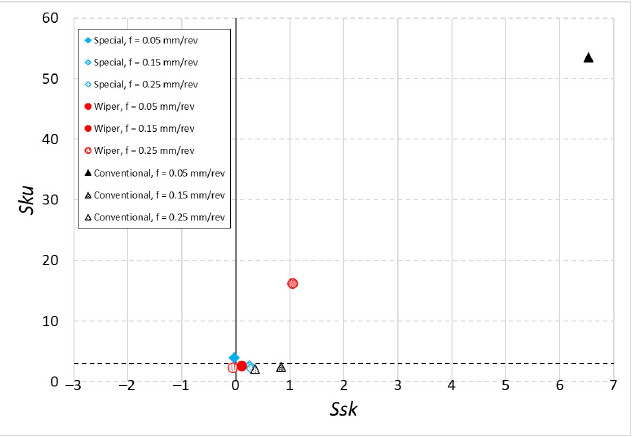
Figure 10. The Sku–Ssk map after dry machining.